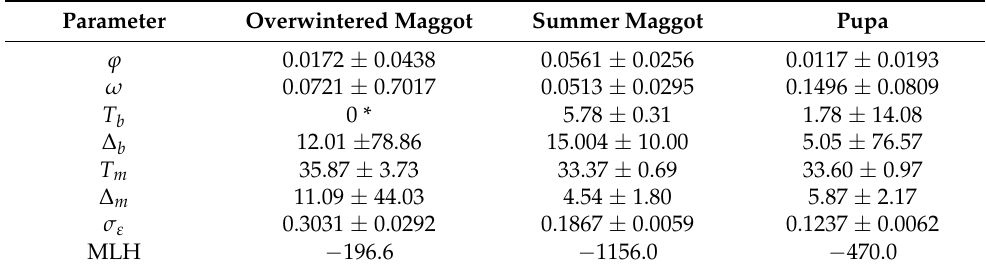
Table 1. Parameter estimates for Equation (1) describing the developmental responses of A. interrupta to temperature, obtained from SAS procedure NLMIXED. Parameter Overwintered Maggot Summer Maggot Pupa